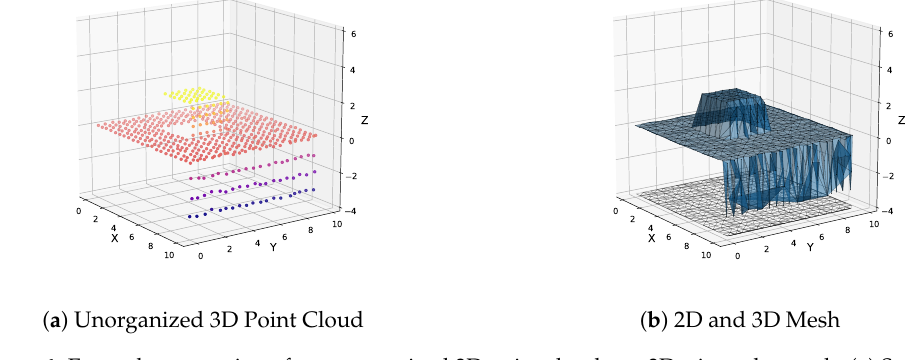
Figure 4. Example conversion of an unorganized 3D point cloud to a 3D triangular mesh. ( a ) Synthetic point cloud of a rooftop scene generated from an overhead laser scanner. A single wall is captured because the scanner is slightly angled; ( b ) The point cloud is projected to the xy plane and triangulated, generating the dual 3D mesh. Only planes aligned with the xy plane can be